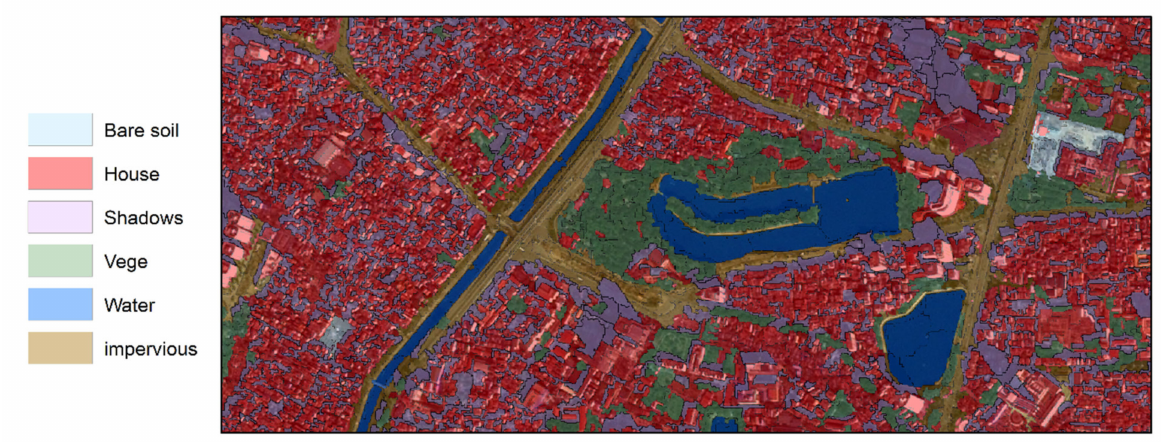
Figure 1. A subset of the study area. The image objects are set partly transparent and overlaid to SPOT image for